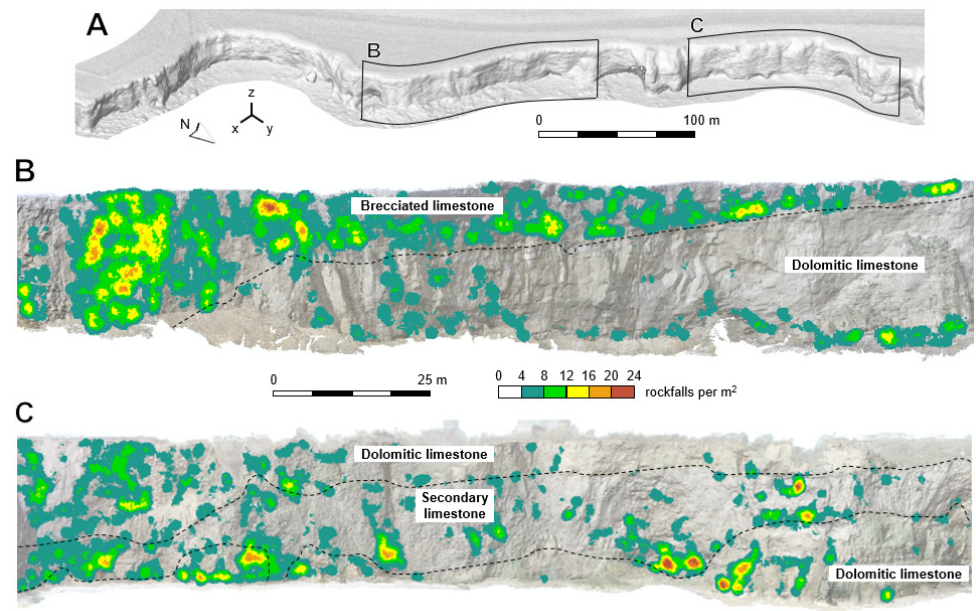
Figure 4. Rockfall occurrence mapping. ( A ): Oblique, hill-shaded DEM showing site context, showing the location of panels B and C . ( B , C ): Rockfall density maps. Density mapping comprises data from the full 2 year rockfall inventory, displayed as rockfalls per unit area of cliff face (m 2 ). Lithological boundaries also shown for reference.